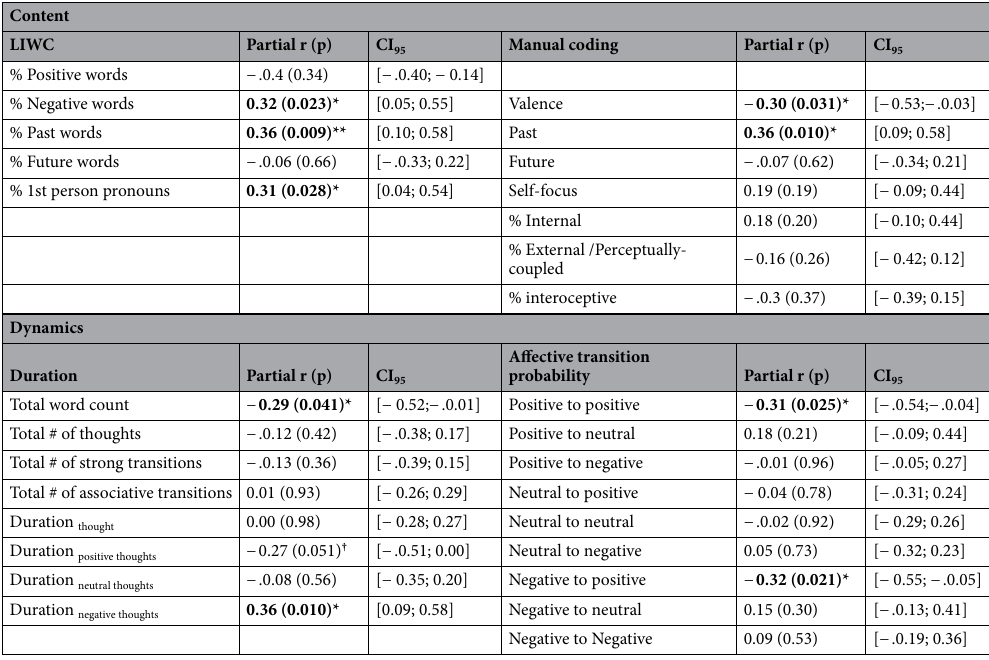
Table 3. Thought content and dynamic correlates of trait brooding. Partial correlations between trait brooding scores and all content and dynamic variables of interest are shown. Partial correlations controlled for perceived censorship and daily thought similarity. For measures of duration, they also controlled for total word count. MNW = Mean Number of Words. Highlighted in bold are statistically significant partial correlations at p < .05. ** P < .01, * P < .05, † <